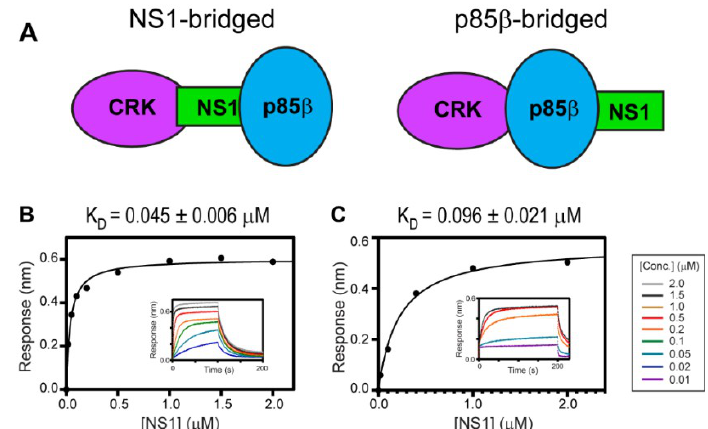
Figure 4. Ternary interaction between 1918 NS1, p85 β , and CRK. ( A ) Schematic showing the NS1-bridged (left) and p85 β -bridged (right) ternary complex. BLI-derived binding isotherms between the 1918NS1 ED-CTT :p85 β complex and ( B ) CRK-II and ( C ) CRK-L. Insets: representative BLI sensorgrams with different analyte concentrations are shown by different colors. K D values and uncertainties are the global fitting result of three repeated data.